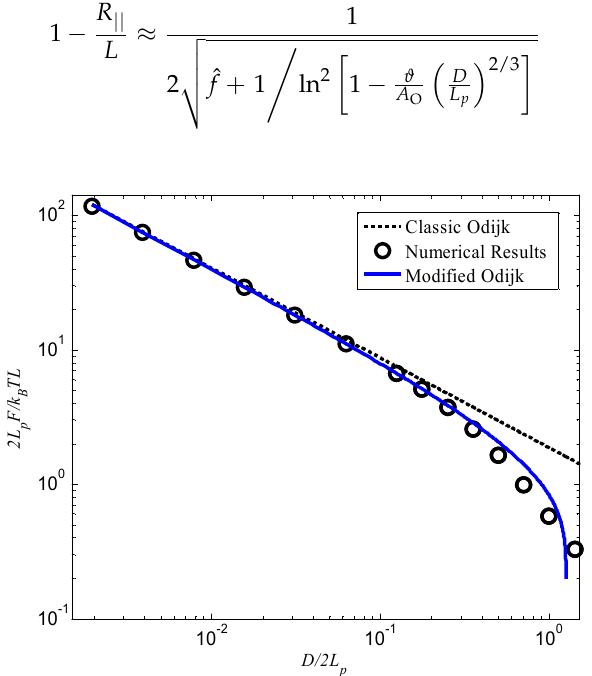
Figure 3. Normalized free energy as a function of the relative confinement diameter D /2 L p for the circular confinement problem.